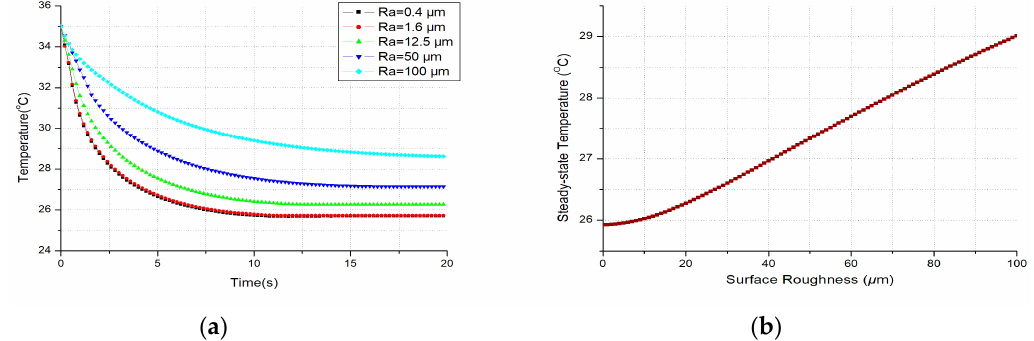
Figure 4. The simulations for different surface roughness of SS: ( a ) The temperature evolutions at thermoreceptors; ( b ) The relationship between surface roughness and steady-state temperature at thermoreceptors.